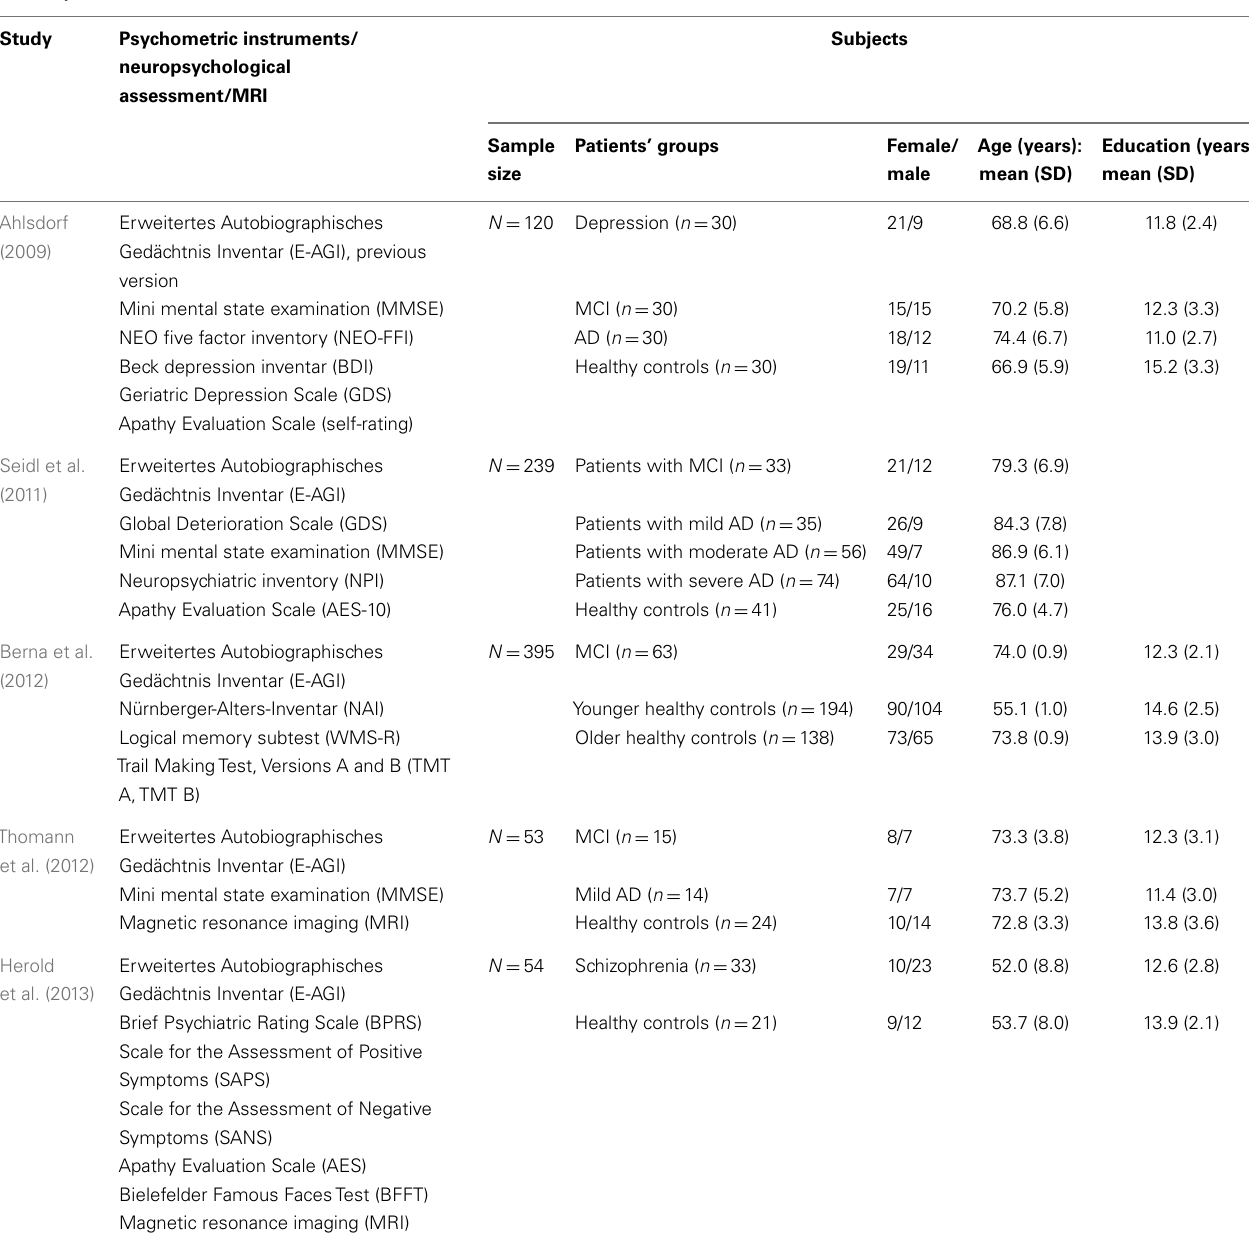
Table 1 | Studies onABM in major depression, MCI,AD, and chronic schizophrenia